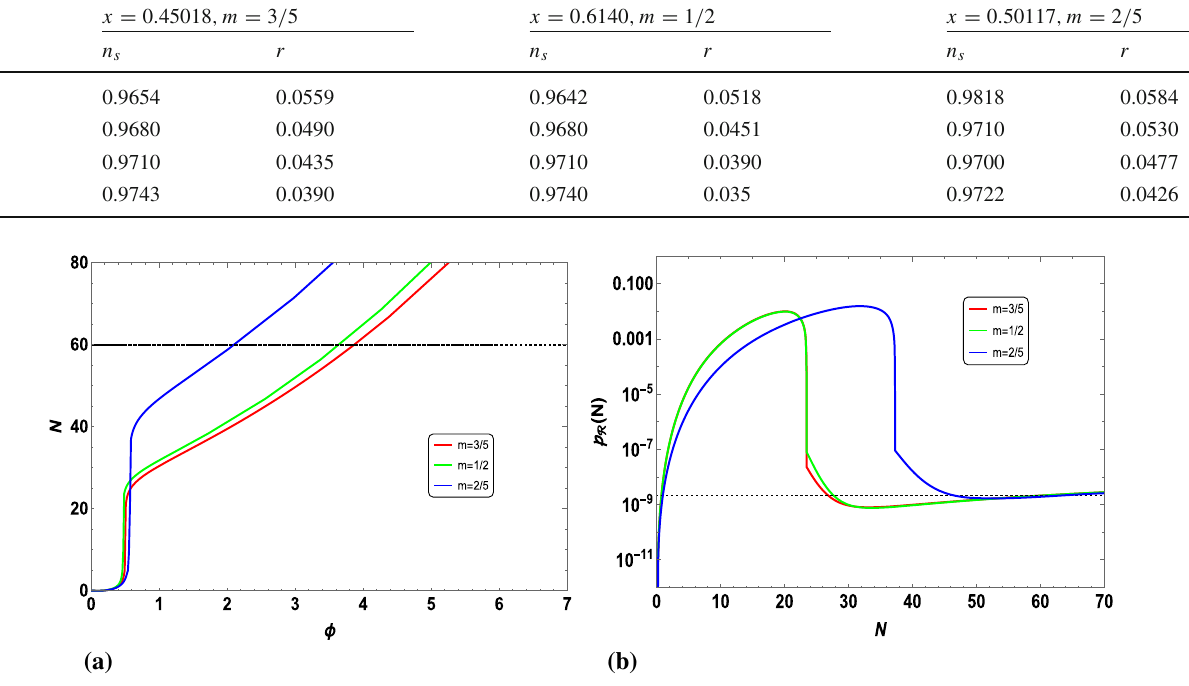
Fig. 1 Left panel: three different colors correspond to three different values of potential parameter x . Red color corresponds to x = 0 . 45018, green is for x = 0 . 6140 and blue stands for x = 0 . 50117. The Number of e-folds ( N ) as a function of the scalar field ( φ ). The dotted black line corresponds to the N = 60. Right panel: the scalar power spec- trum as a function of the number of e-folds ( N ). Three different colors correspond to three different values of potential parameter x . Red color